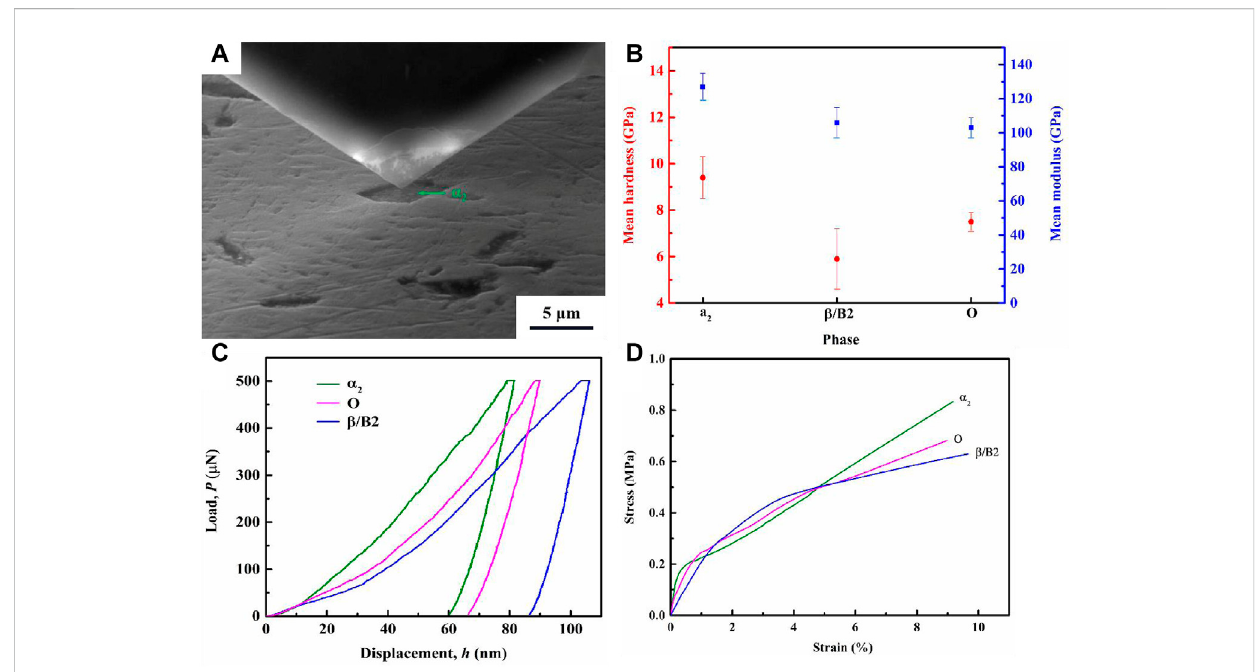
FIGURE 5 In situ nanoindentation test of the three different phases in Ti-22Al-25Nb alloy. (A) Image was extracted from an SEM video recorded during the indentation test; (B) mean hardness and mean Young ’ s modulus of the three different phases; (C) their typical load – displacement ( P - h ) curves; and (D) their indentation stress – strain ( σ - ε )